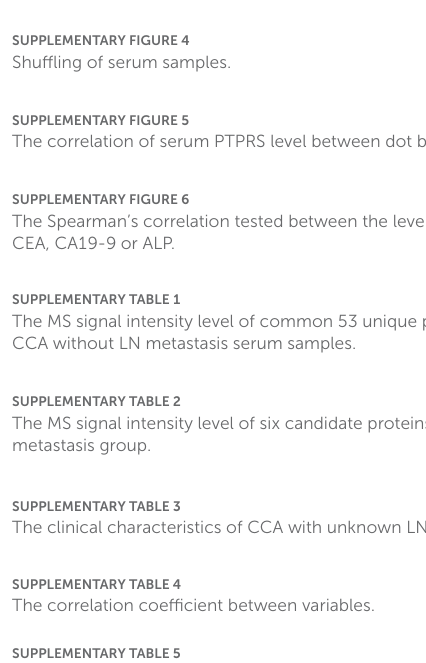
SUPPLEMENTARYFIGURE3 Representative dot blot membranes of PTPRS in serum samples obtained from the Amersham imager 600 analyzer.